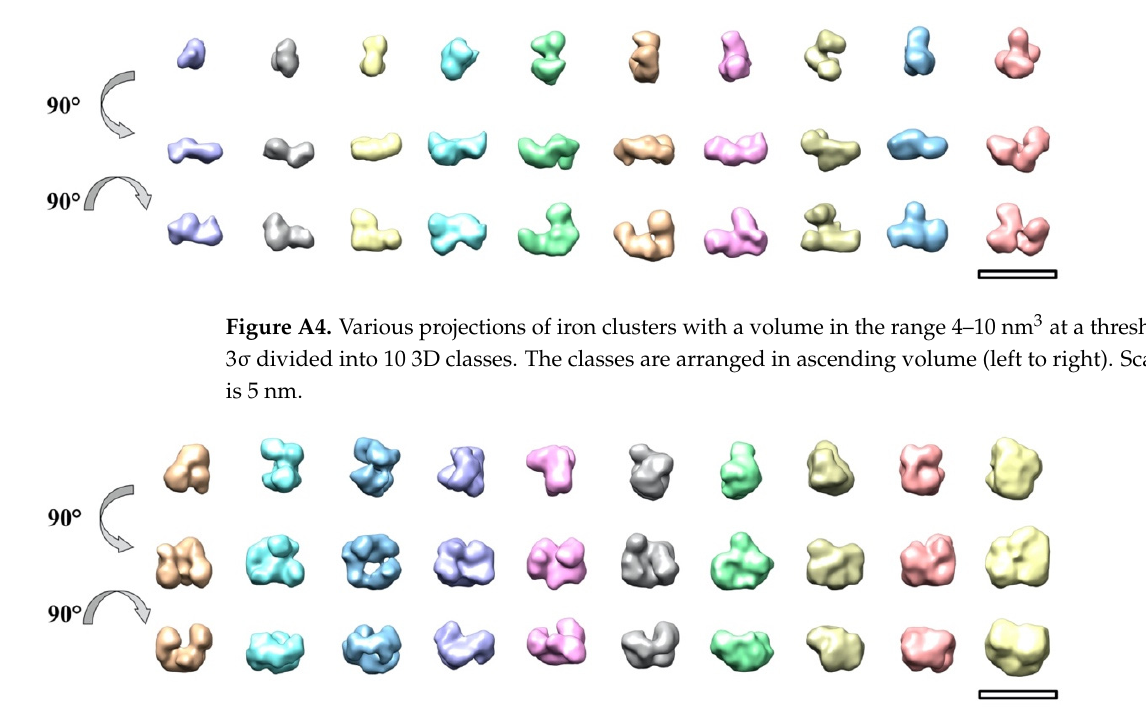
Figure A3. Various projections of iron clusters with a volume less than 4 nm 3 at a threshold of 3 σ divided into 5 3D classes. The classes are arranged in ascending volume (left to right). Scale bar is 5 nm.